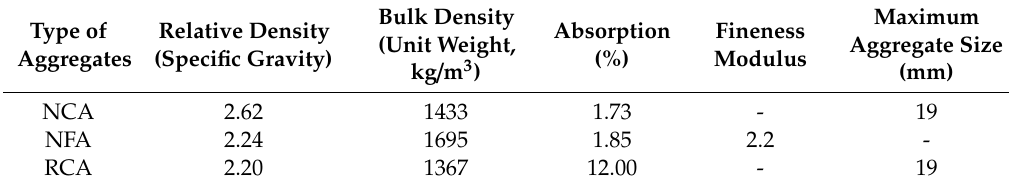
Table 1. Physical properties of the natural coarse aggregate (NCA), natural fine aggregate (NFA) and recycled coarse aggregate (RCA).